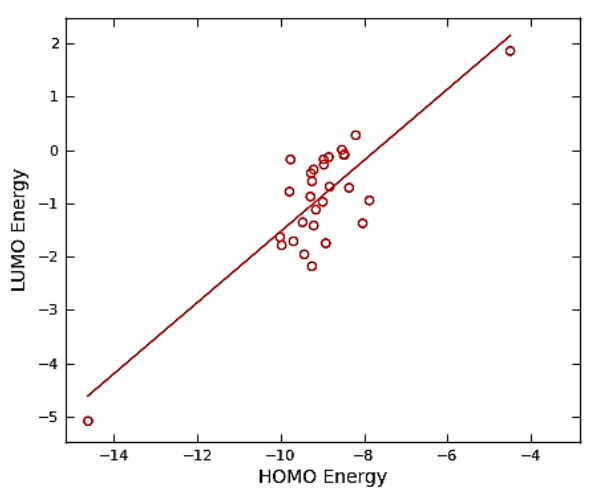
Figure S6. Plot represents HOMO vs LUMO energy, y = 0.67x + 5.14 (R 2 =